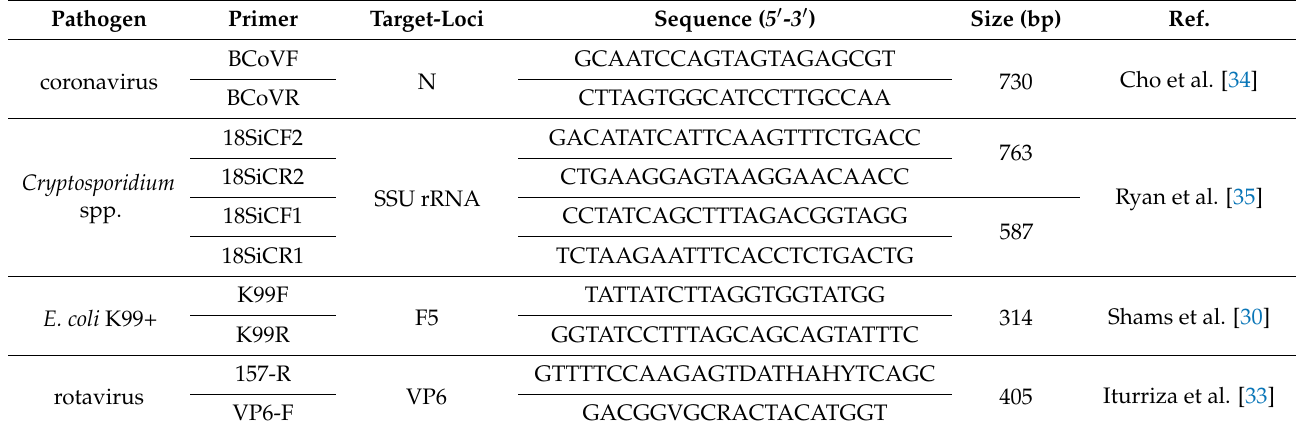
Table 1. The detailed descriptions of primers for calf diarrhea PCR screening